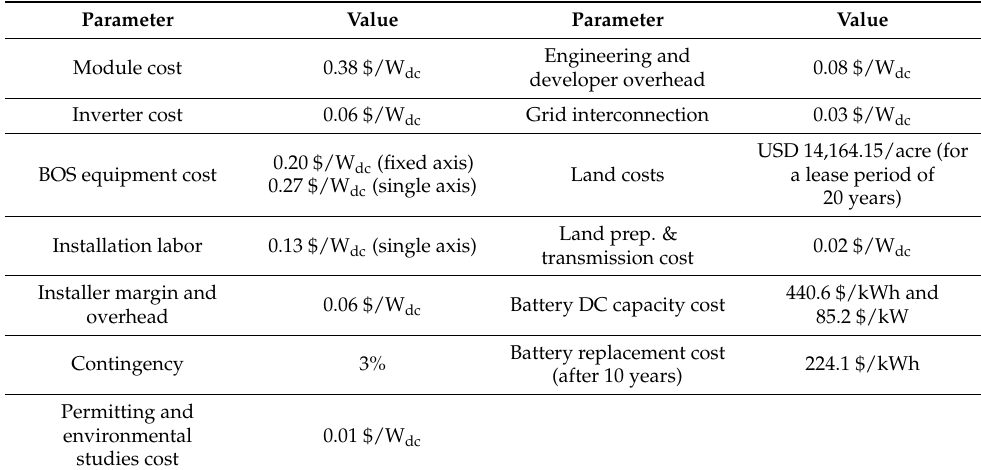
Table 3. Capital cost